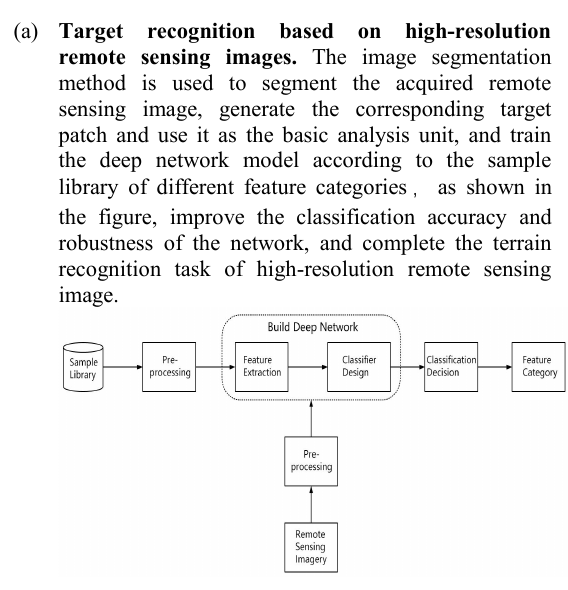
Fig. 5 Classification framework of high-resolution